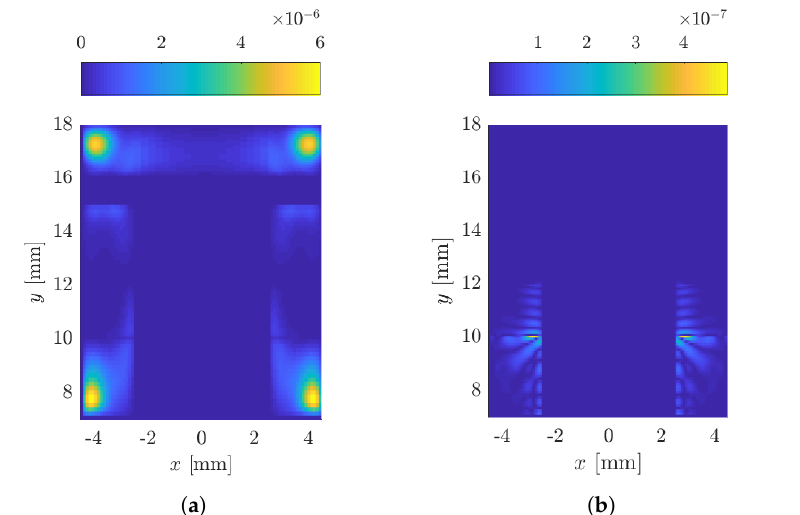
Figure 5. Differences in the magnetic vector potential distribution in [Vs/m] between ( a ) IGA(SI)-IGA(NR) and ( b ) SEM(SI)-SEM(NR) solutions, all using the reference discretizations.